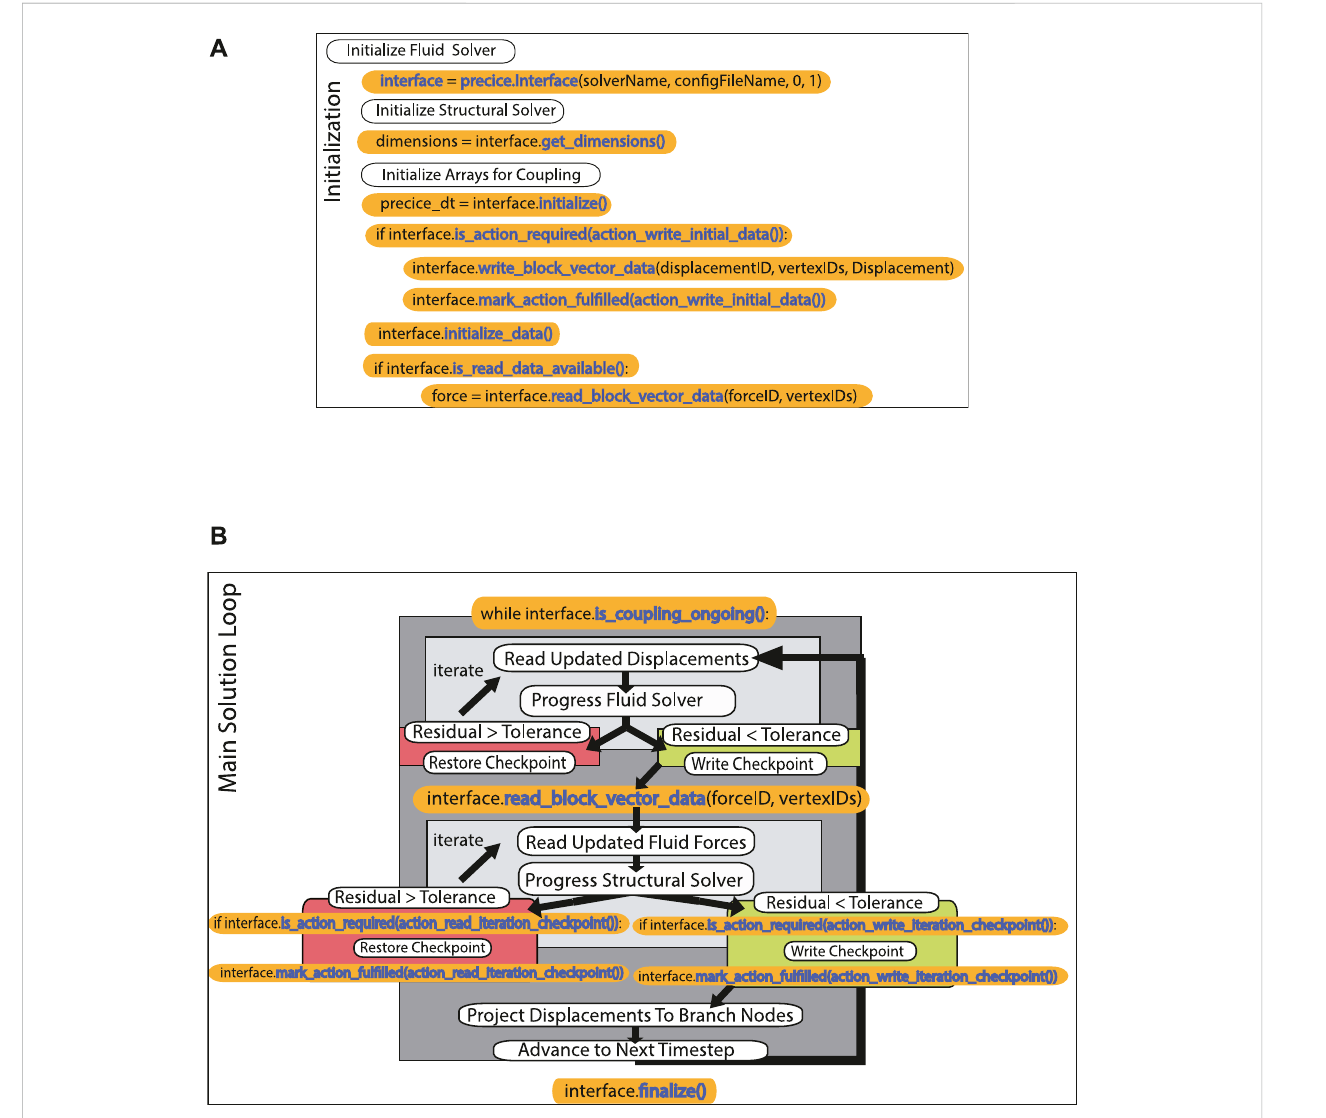
FIGURE 1 (A) preCICE commands utilized within FOAMySees initialization, (B) Diagram of preCICE subroutine calls within FOAMySees. This diagram is solely intended for informing about preCICE API function calls and where these calls are necessary, and is not indicative of the full coupling procedures for FOAMySees. For speci fi c location of preCICE API function calls within FOAMySees, refer to the FOAMySees source